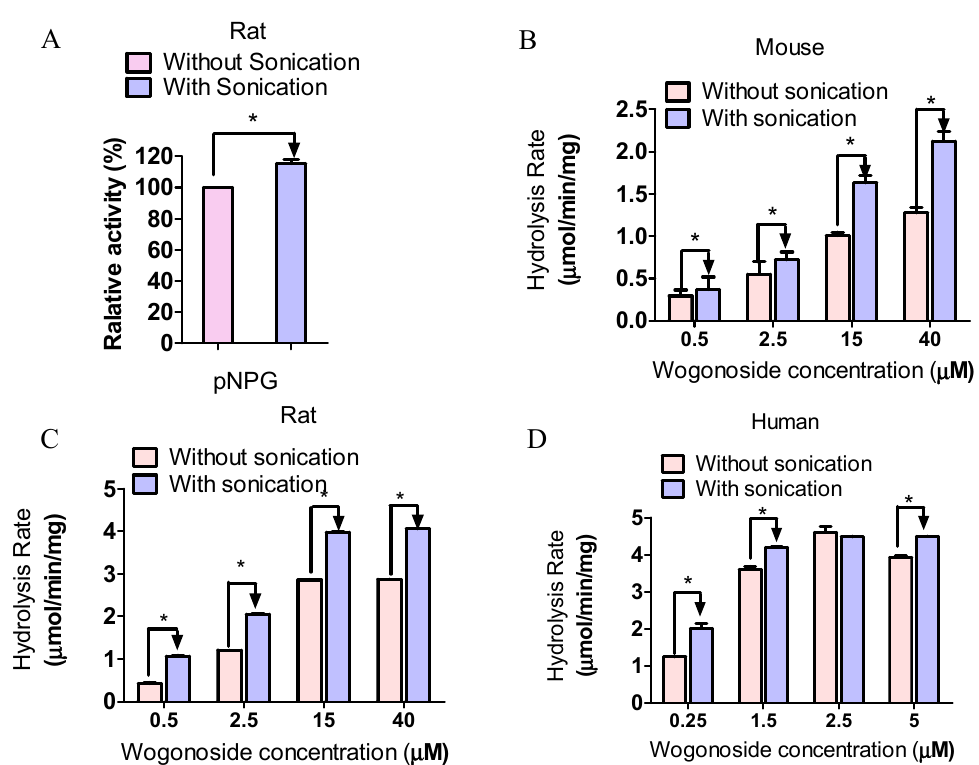
Figure 3. The impact of enzyme preparation on pNPG ( A ) and wogonoside hydrolysis ( B , mouse; C , rat; D , human). pNPG (final concentration, 1 mM) and/or wogonoside were incubated with the enzymes for 30 min at 37 °C (n = 3, * p < 0.05, t -test).